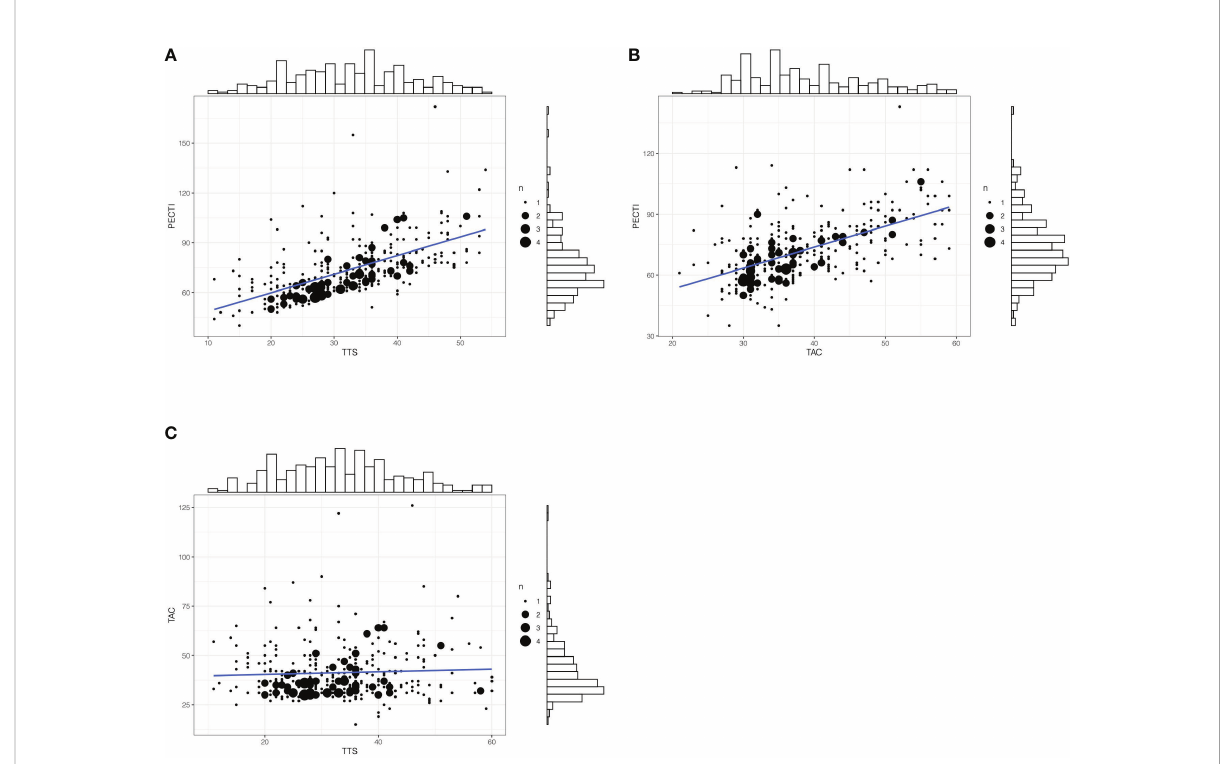
FIGURE 4 The matched counts plot with marginal histogram of time interval. (A) Correlationship between PECTI and TTS; (B) Correlationship between PECTI and TAC; (C) Correlationship between TAC and TTS. The plot would illustrate the collinearity between PECTI and TTS. The size of circles denotes the extent of overlapping points. PECTI, perioperative chemotherapy time interval; TTS, time to surgery; TAC, time to adjuvant chemotherapy.